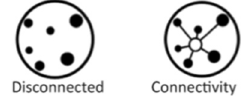
Figure 11. Encourage Walkability and Reduce Car Dependency.